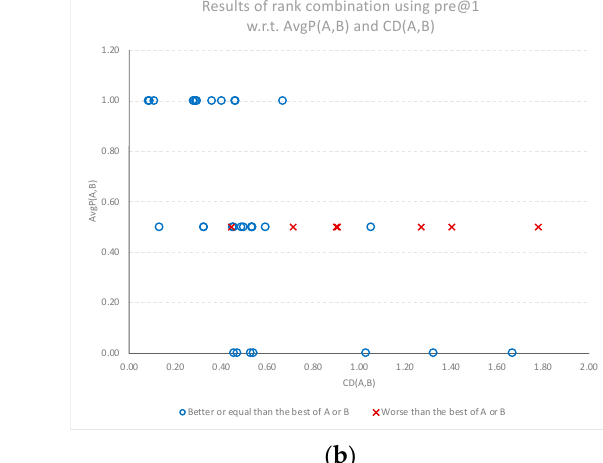
Figure 6. Relative performance of the combined models compared to the best of the individual mod- els (best of A or B) for the top classification, plotted against the average performance (AvgP) of the individual models and cognitive diversity. ( a ) Results when using score combination SC ( A , B ). ( b ) Results when using rank combination RC ( A , B ) .